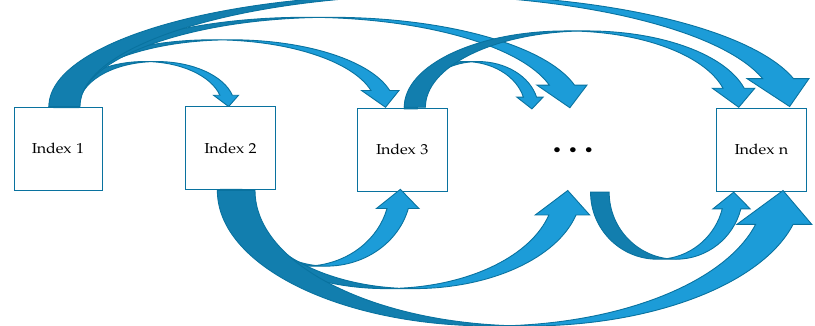
Figure 2. Comparison of importance of index by analytic hierarchy process (AHP) method.